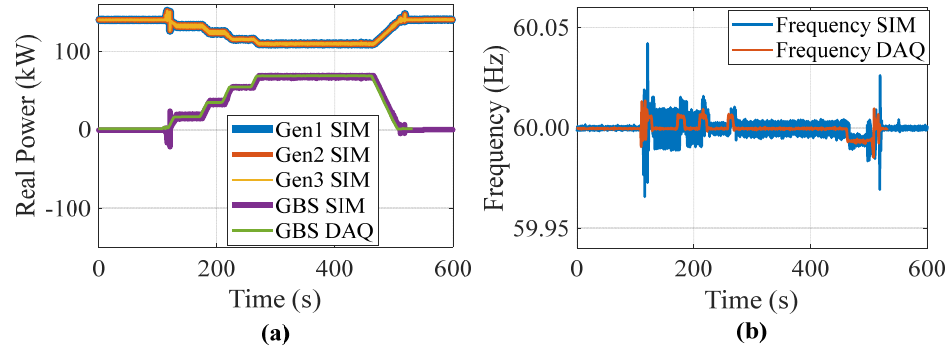
Figure 15. Results from the PHIL incorporation of 100 kW ABB PCS100 operated in VGM-PQ mode. ( a ) Comparison between the power output vs. time for the simulated generators and the GBS and the real power flow measured in the laboratory DAQ data. ( b ) Comparison between system’s frequency vs. time for the simulated and laboratory DAQ data.